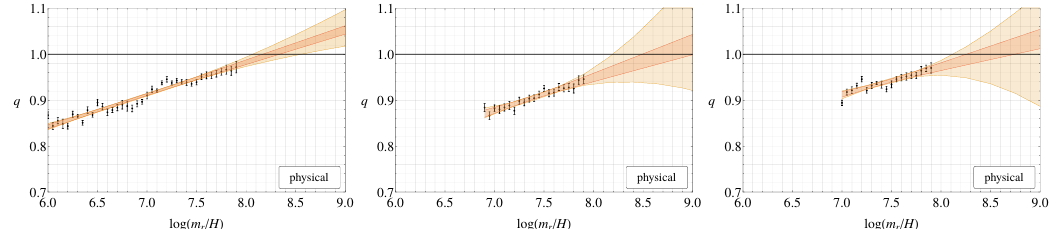
Figure 18: The best fit values of q as a function of log for physical strings, with statistical error bars. Left: results with q fit over the momentum range [ 30 H , m for data with lattice spacing at the final time m [ 50 H , m / 6 ] for m ∆ = 1. Right: q fit in the range [ 50 H , m r r a In all plots the light and dark red bands represent the best linear and quadratic fits to q vs log with standard errors on the